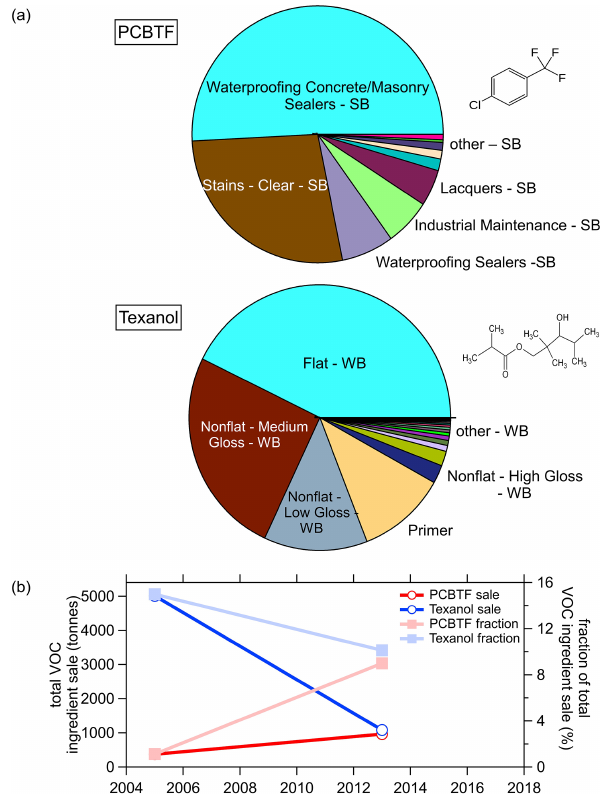
Figure 10. (a) PCBTF and Texanol use in solvent-borne (SB) and water-borne (WB) product categories in California and their (b) trends in sales and